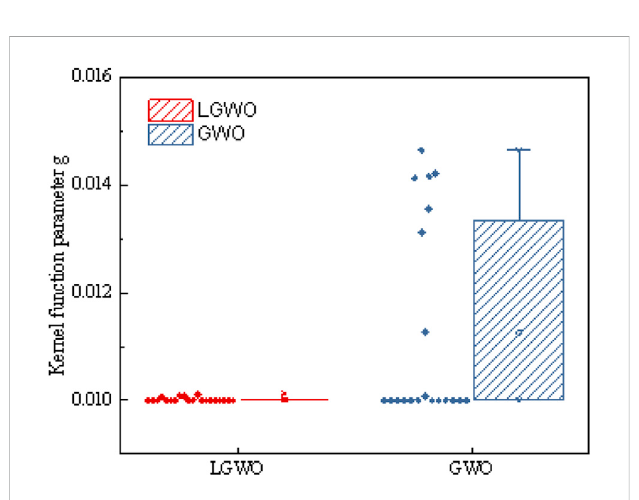
FIGURE 15 The distribution of parameter σ at 20 independent runs of the LGWO and GWO